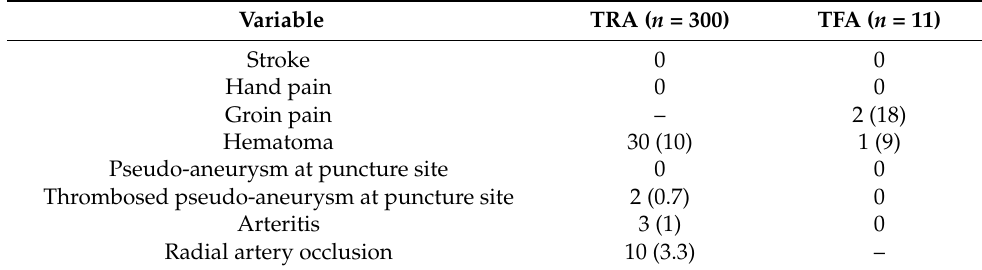
Table 5. Access-site adverse